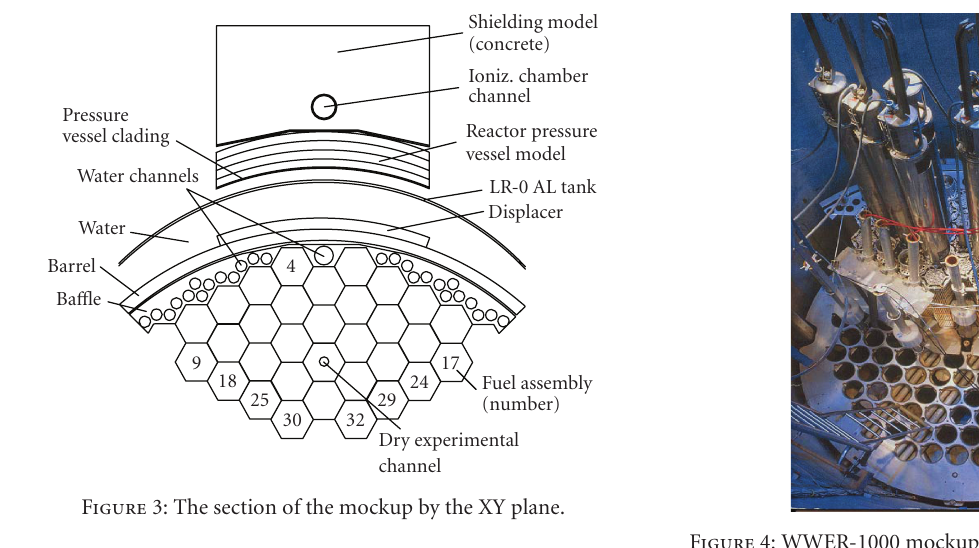
Figure 4: WWER-1000 mockup general view on reactor